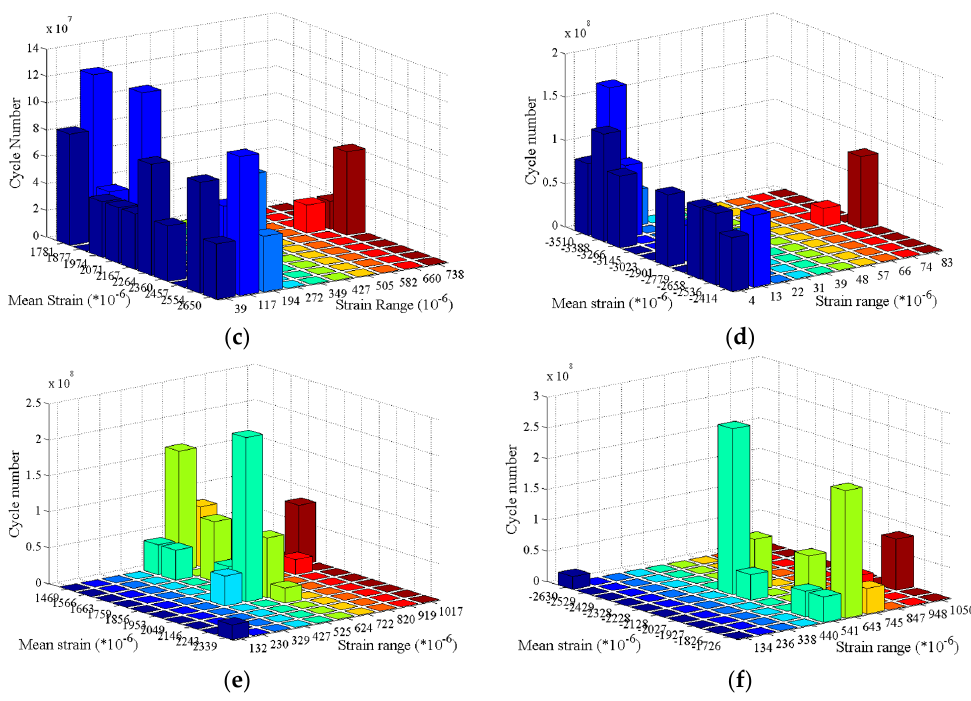
Figure 5. Rain-flow counting matrix plot: ( a ) Node 1; ( b ) Node 2; ( c ) Node 3; ( d ) Node 4; ( e ) Node 5; ( f ) Node 6.